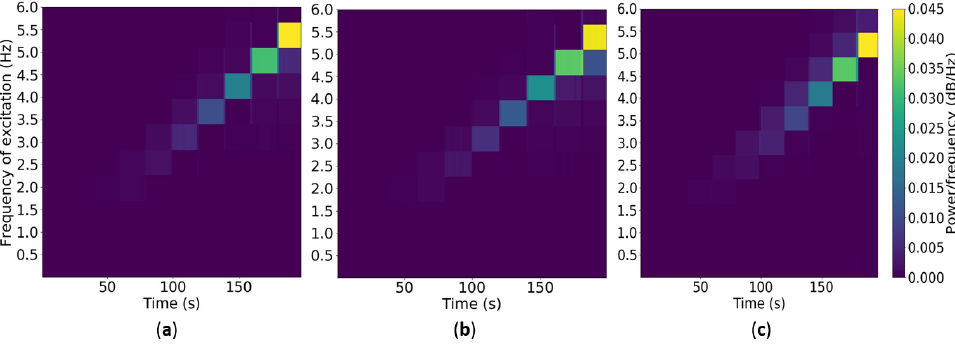
Figure 16. Spectrograms for the 0.25 cm displacement frequency chirp: ( a ) PCB L74 spectrogram.